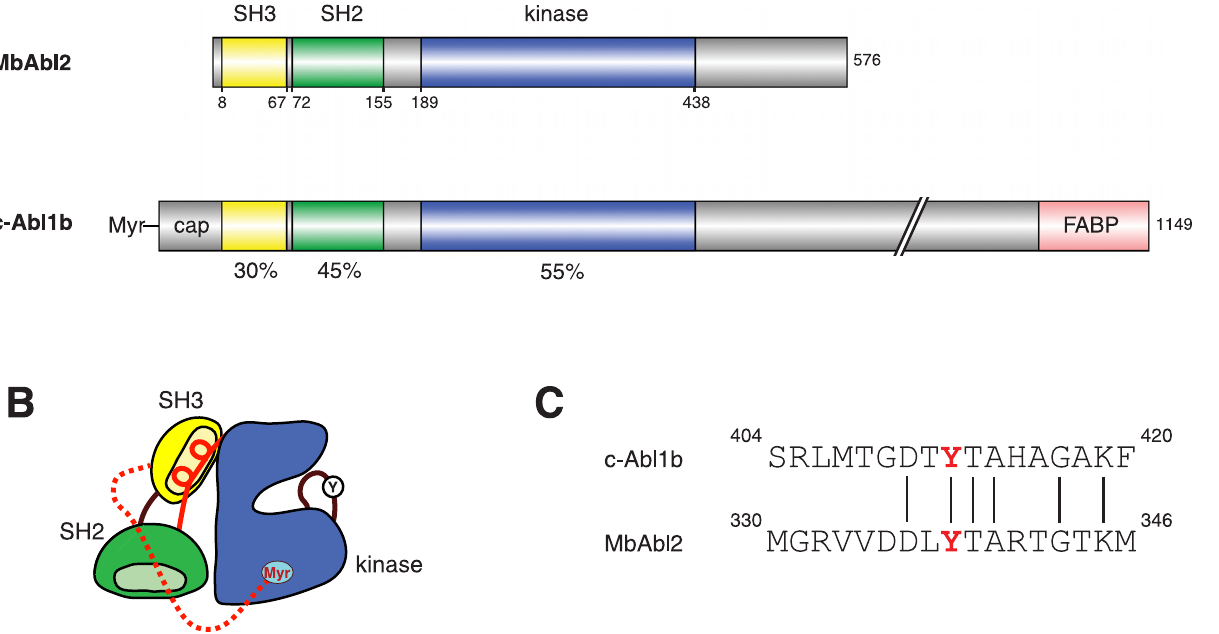
PLOS ONE | DOI:10.1371/journal.pone.0131062 June 19,